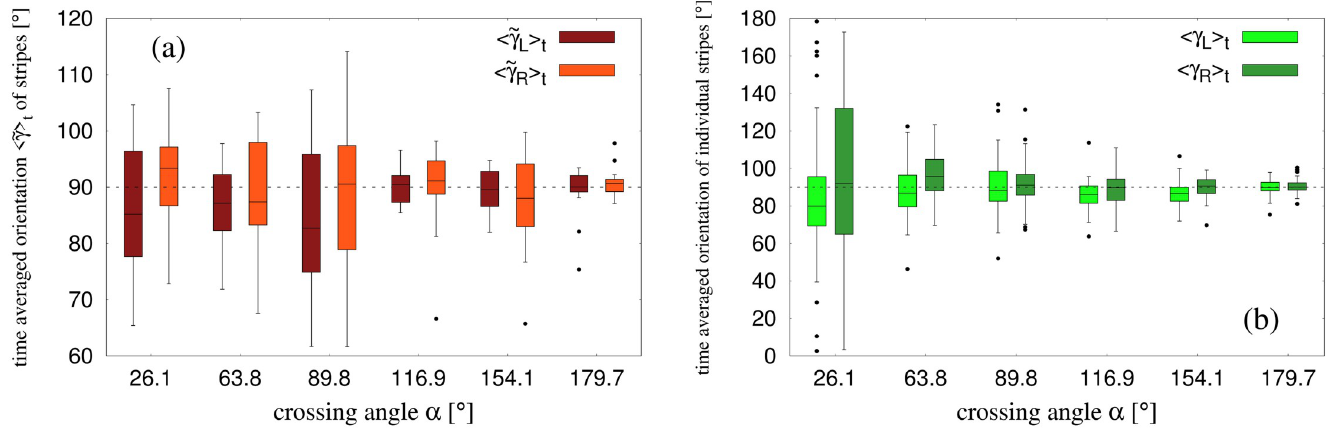
Fig 8. Time averaged orientation of stripes. (a) Boxplots for h ~ g analysis using pattern matching technique. (b) Boxplots for h γ